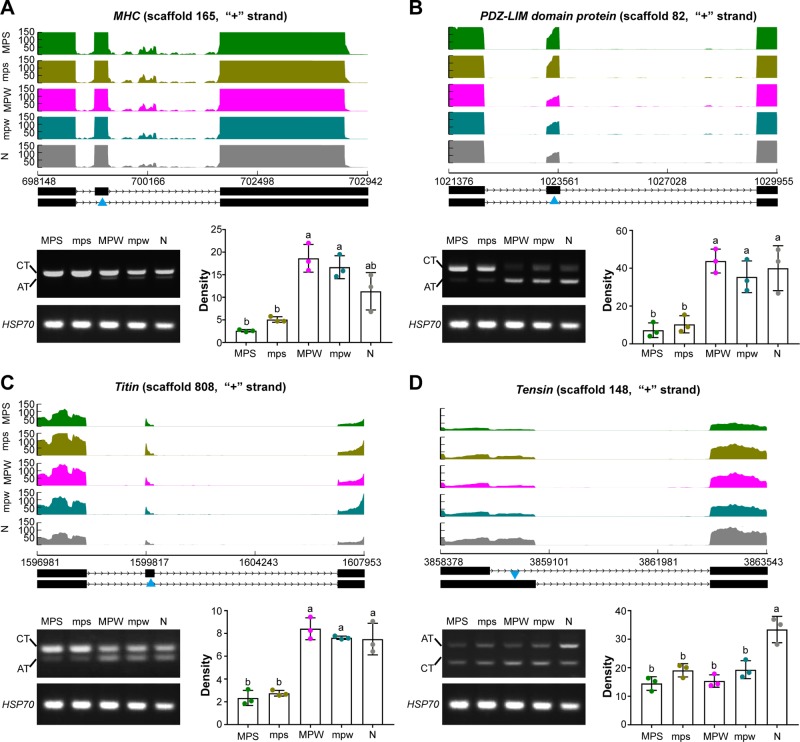
The four differentially spliced muscle genes among the five immature castes. SE events of (A)
MHC, (B)
PDZ-LIM domain protein and (C)
Titin, and (D) A5SS event of Tensin were identified by RNA-Seq analysis and validated by RT-PCR. In the graphic representation of Sashimi plots, the y-axis refers to per-base expression, and the x-axis refers to genomic coordinates. The quantified mRNA isoforms are shown on the bottom (exons in black, introns as lines with arrow-heads), and blue triangles indicate the regions undergoing AS events. Changes in CTs and ATs among the five immature castes were analyzed by RT-PCR (left bottom). Densities of ATs (right bottom) were calculated from bands in the electrophoretogram at the left bottom, and the different lowercase letters over the bars denote significant differences in density of AT bands among the five immature castes (P < 0.05). AT, alternative transcript; CT, constitutive transcript, N, nymphs; MPS, major presoldiers; mps, minor presoldiers; MPW, major preworkers; mpw, minor preworkers.